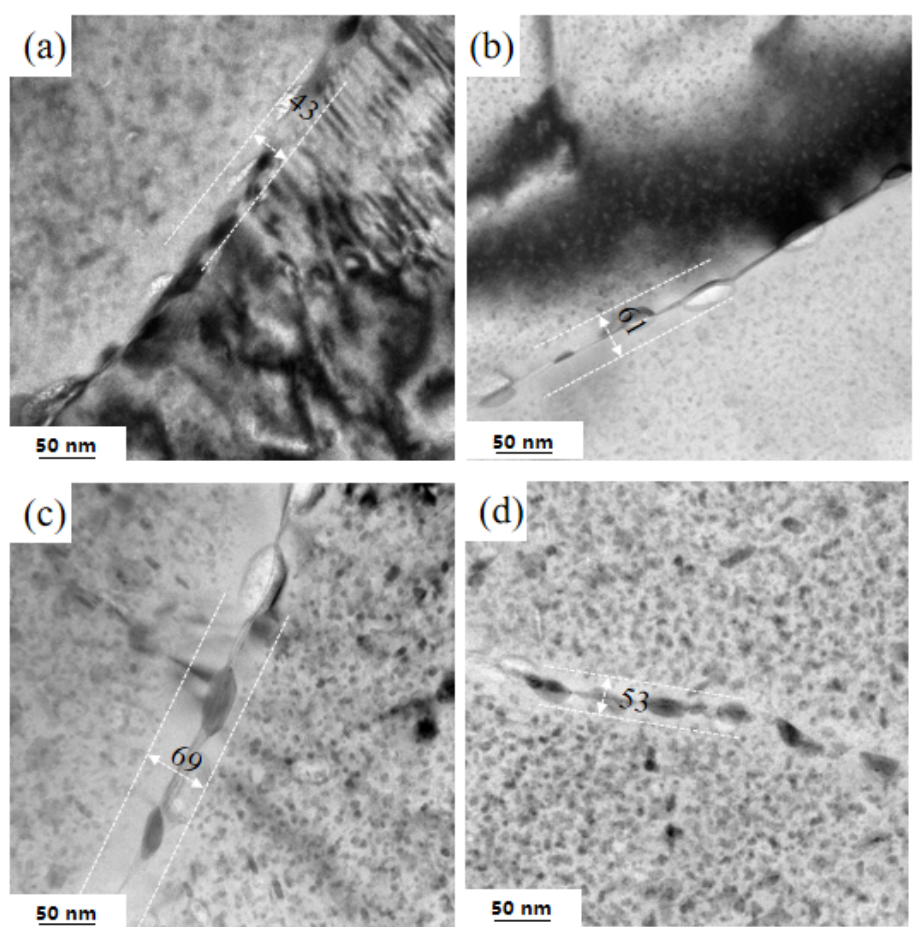
Figure 13. The TEM images of grain boundary precipitates of 7B04-P al alloy under applied stress of 250 MPa at 160 °C during creep aging: ( a ) 1 h; ( b ) 4 h; ( c ) 8 h;( d ) applied stress of 10 MPa for 8 h.